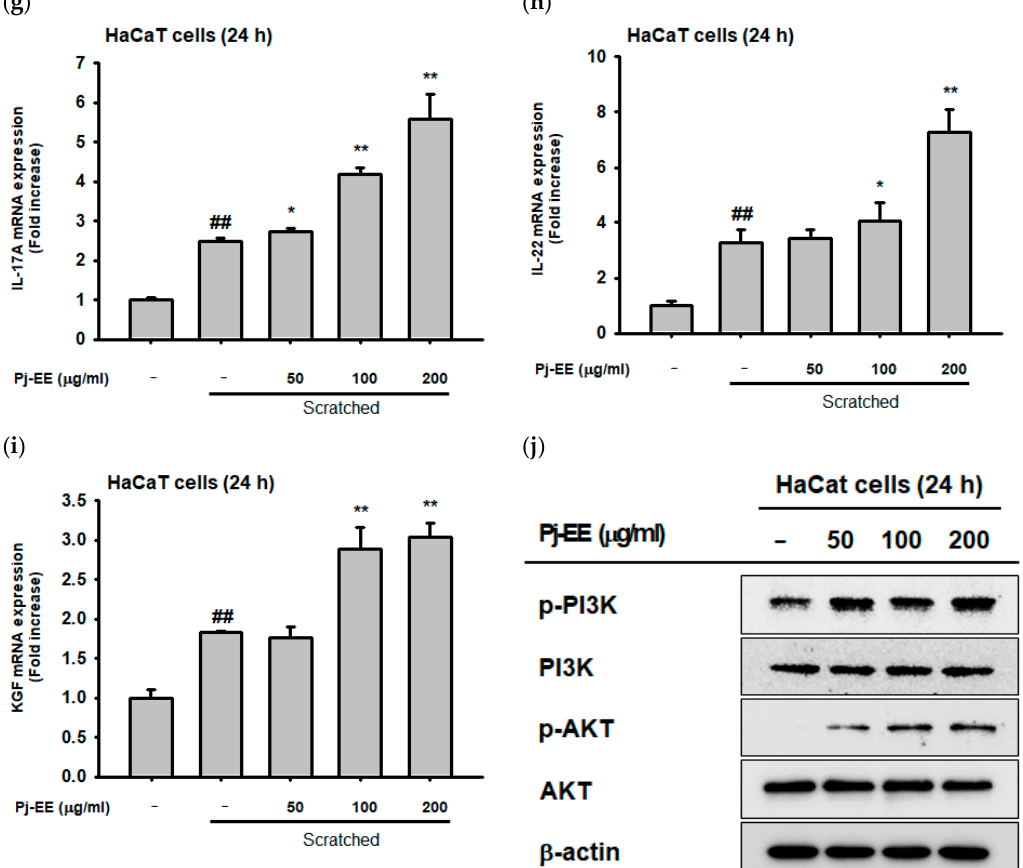
Figure 5. Effects of Pj–EE on cellular scratching, cell migration, and inflammatory genes. ( a ) Measurement of cell viability in Pj–EE-pretreated and scratched HaCaT cells. ( b , c ) Cell migration in Pj–EE-pretreated scratched HaCaT cells. ( d ) Cell proliferation in HaCaT cells treated with Pj–EE. ( e – i ) RT-PCR and real-time PCR analyses of migration and inflammatory gene expression in Pj–EE-treated HaCaT cells. ( j ) Western blot analysis of the expression of the EGFR signaling pathway in Pj–EE-pretreated scratched HaCaT cells. Statistical signi fi cance was evaluated using the Kruskal–Wallis/Mann–Whitney U test. ## p < 0.05 compared with the normal group (f–i: Loliolide − /Scratched − ), and * p < 0.05 and ** p < 0.01 compared with the control group (c and d: Pj–EE − , and f–i: Loliolide − /Scratched+).